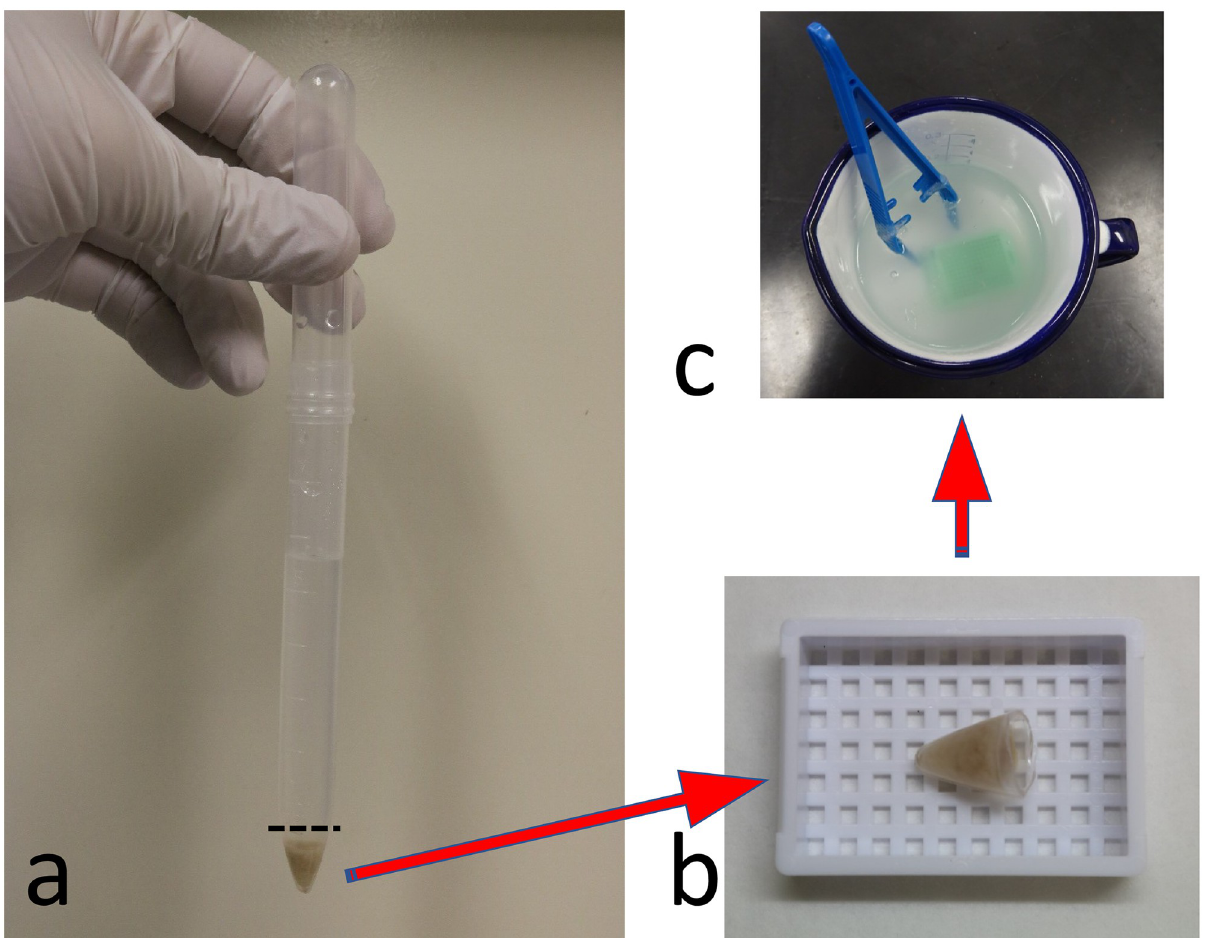
Fig 5. Procedure of cell block. (A) Cell pellet made from pleural fluid. Floating single or clustered cells in the pleural fluid were centrifuged at 1,500 × 100 g for 5 min. (B) Cell pellet in the cassette. The cell pellet was placed in the cassette together with the cut end of the centrifuge tube. (C) Paraffin embedding within each